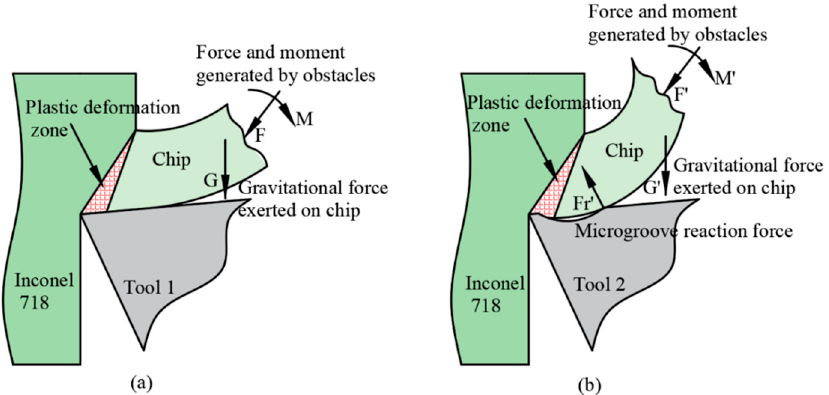
Figure 8. Deformation analysis of chips during the turning of Inconel 718 for both tools: ( a ) the chip deformation analysis for Tool 1, ( b ) the chip deformation analysis for Tool 2.